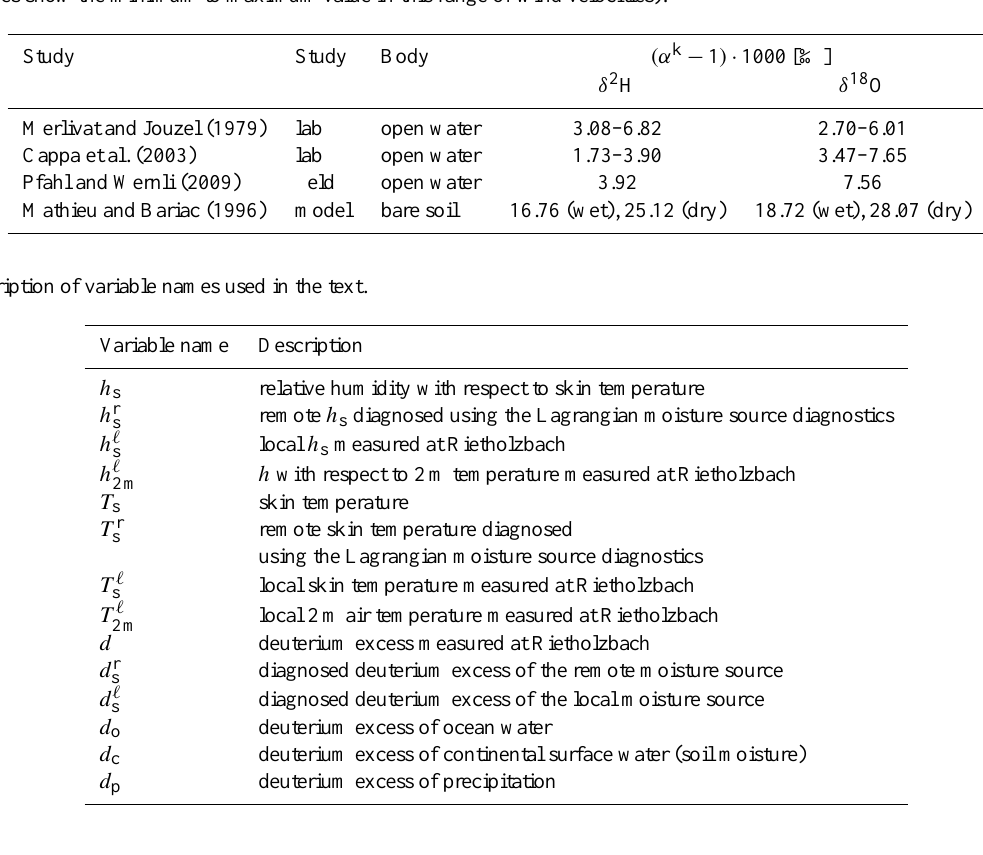
Table 1. Comparison of kinetic fractionation factors α k found in the literature, for 10m wind velocities between u 10m = 0s and u 10m = 12ms − 1 (values show the minimum to maximum value in this range of wind velocities).